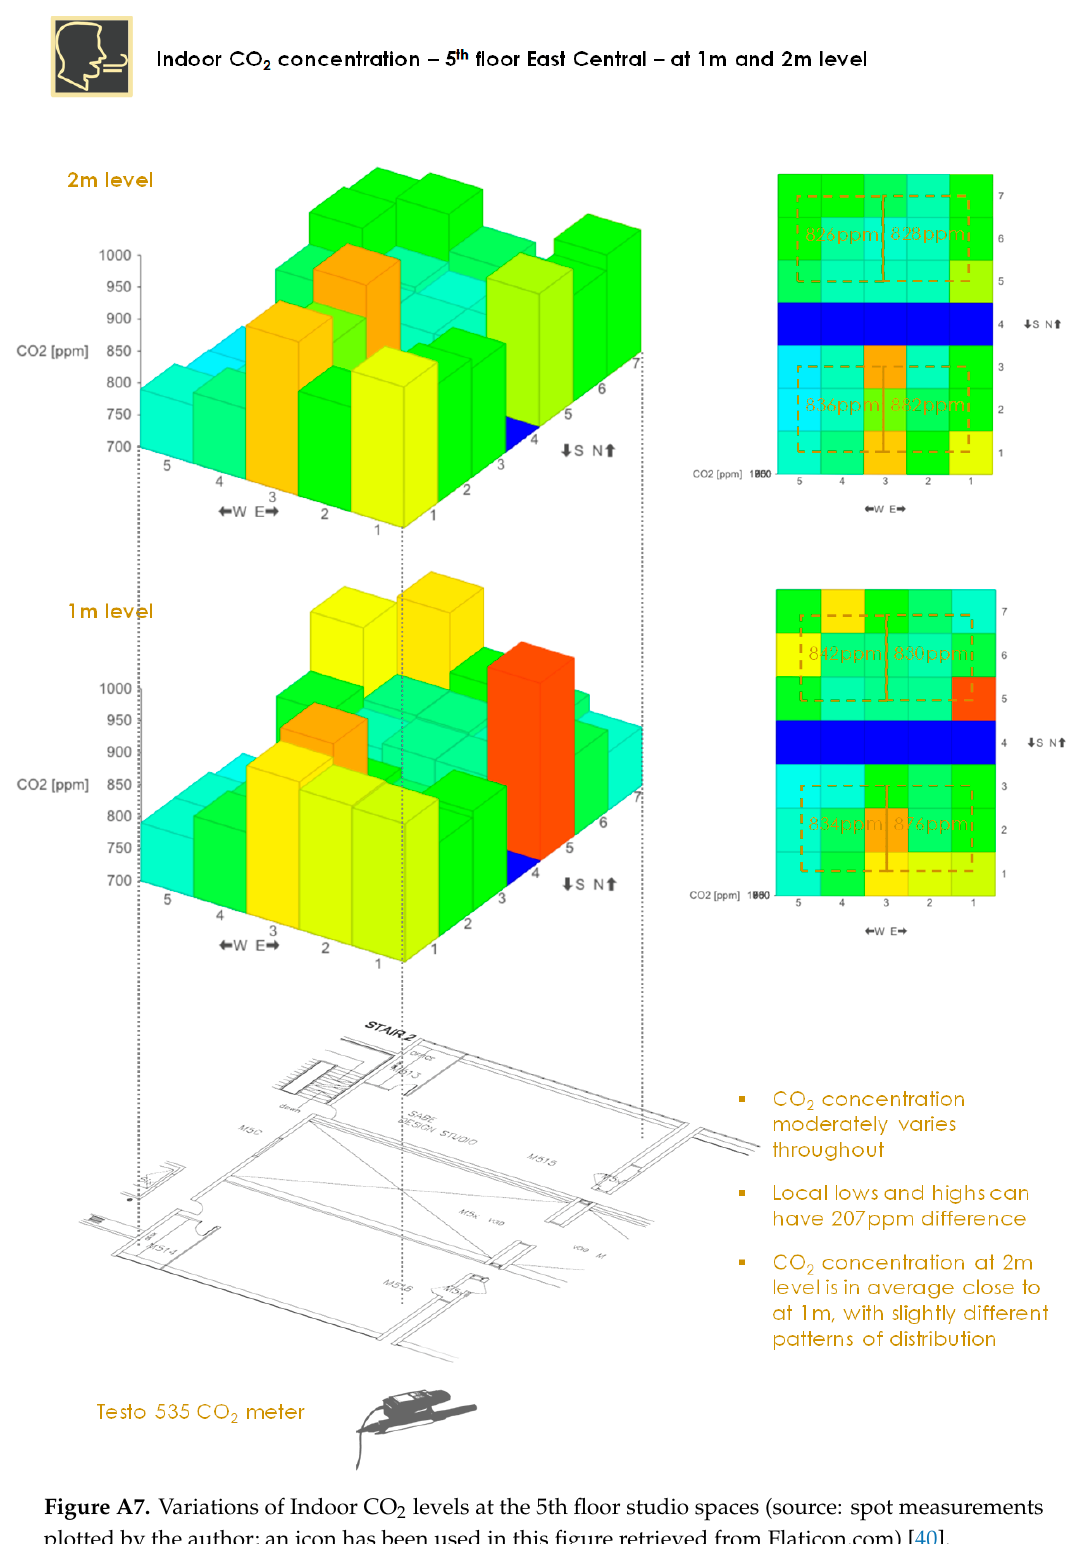
Figure A7. Variations of Indoor CO 2 levels at the 5th floor studio spaces (source: spot measurements plotted by the author; an icon has been used in this figure retrieved from Flaticon.com) [40].